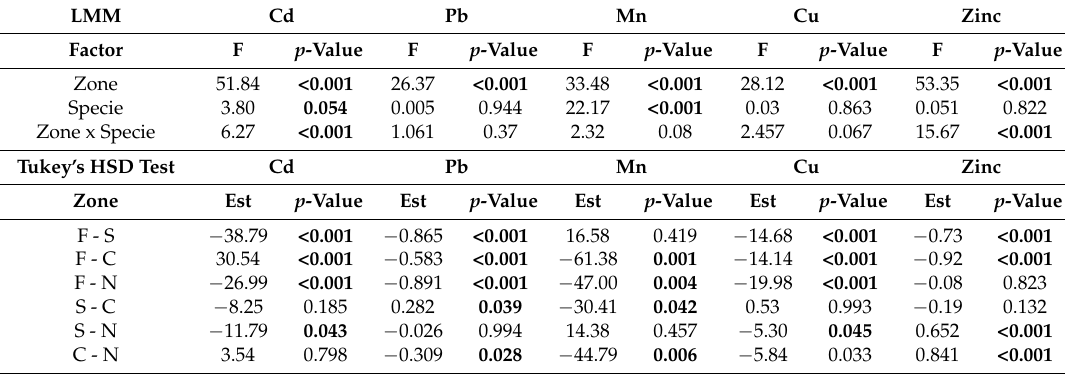
Table 1. Linear mixed model (LMM) and a post-hoc Tukey test of heavy metal accumulation in Parmotrema arnoldii and Tillandsia usneoides according to the different study sites. F-value = statistical; p < 0.05 is considered significant.